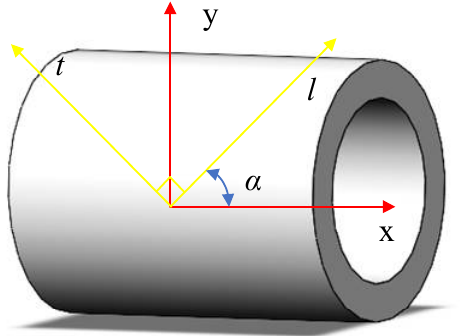
Figure 5. Primary reference frame x-y on axisymmetric parts, fiber direction l , tilt angle α and fiber normal direction t .